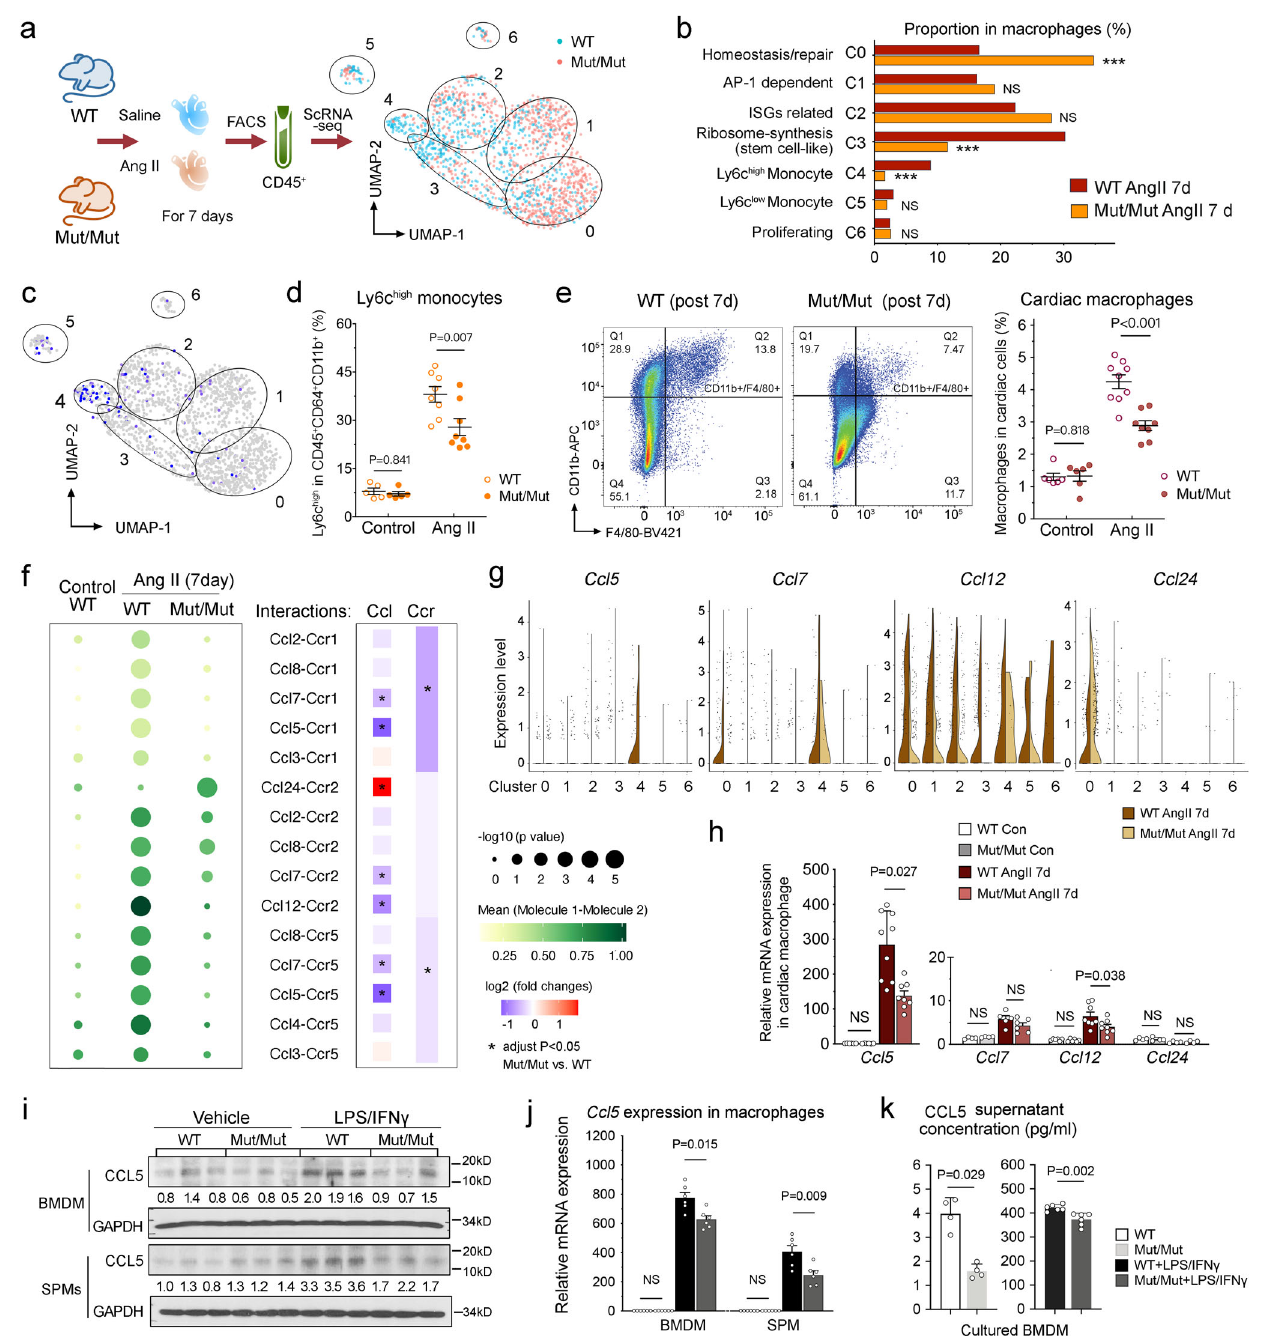
Fig. 2 | WWP2dysfunction regulates macrophage in fi ltrationand expansionin the heart at 7 days post Ang II-infusion. a Schematic representation of the experimentalsetup.SortedliveCD45+cellsfromLVunderwentscRNA-seqanalysis, and seven clusters are represented in the UMAP space. WT, WWP2 wt/wt ; Mut/Mut, WWP2 Mut/Mut . In each experiment, mice were treated with either saline (control) or Ang-II (500ng/kg/min, 7 days). b Bar plots represent the proportions of macro- phage clusters (Fig. 2a) in WT and Mut/Mut following Ang-II treatment. Two- proportion z test, *** P <0.001 Mut/Mut vs WT. c Expression of Ly6c gene incardiac macrophages represented in the UMAP space. d Percentage of Ly6c high cells in WT and Mut/Mut cardiac monocyte compartments, in control or Ang-II-treated mice. n =5 – 8 for each group. e Representative fl ow cytometry for CD11b + /F4/80 + gate in Ang-II-treated WT and Mut/Mut mice (left).Quanti fi cation of cardiacmacrophages in Mut/Mut compared with WT micefollowing Ang-II treatment (right). n =6 – 9 for each group. f Chemokine ligand-receptor pairs (Molecule 1 – 2 pairs) derived by CellPhoneDB analysis in cardiac macrophages, P <0.01 (left). Mean expression of